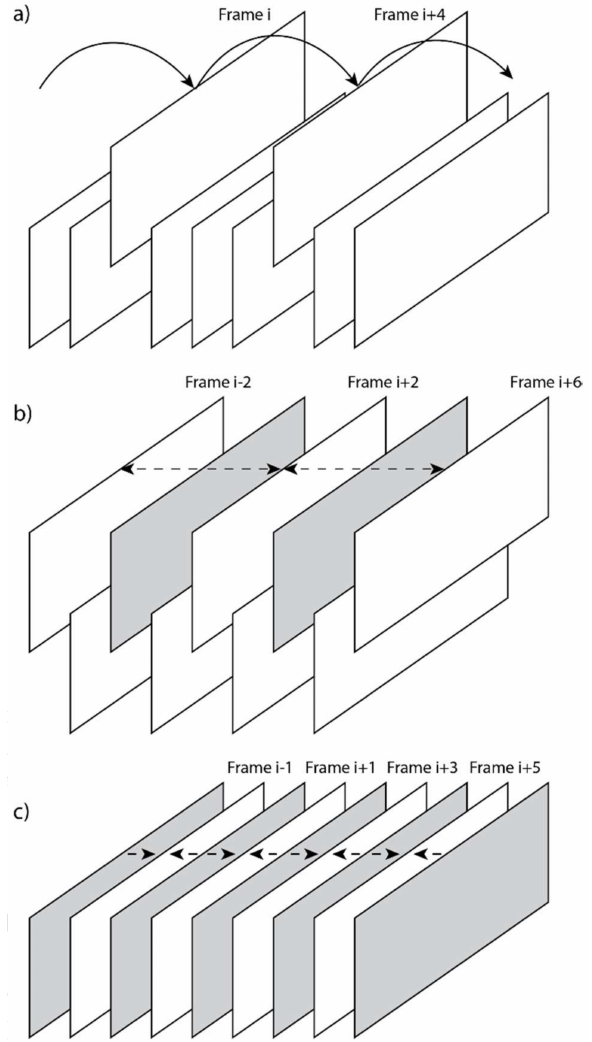
Figure 1. The figure shows which frames to use in ( a ) part 1 and ( b , c ) part 2 (1st and 2nd iteration) of the proposed tracking scheme for k = 4. The squares mark sampled frames and a raised frame marks a frame used in the current iteration. Please note that all frames are raised in ( c ) (2nd iteration). A gray frame marks a frame in which a position for the kernel has been estimated in a previous iteration. The base of the arrows shows the frame in which the kernel is collected and the point of the arrows shows in which frame the kernel is searched for. In ( b , c ) iteration, there are two arrows pointing at each frame in which to estimate the position. The estimated position in these frames is calculated as the average estimated position using two kernels from two different